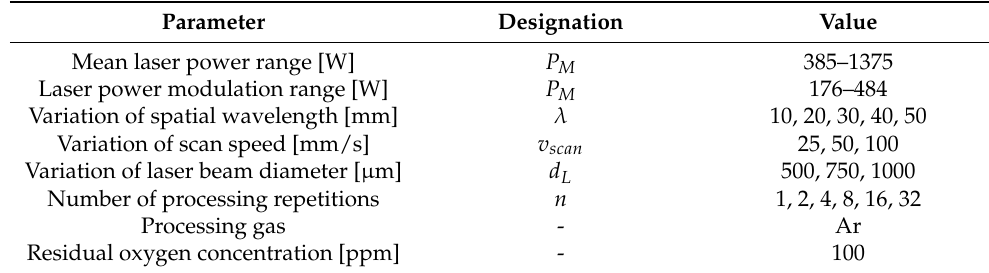
Table 1. Waveshape processing parameters used to obtain the profiles data set.